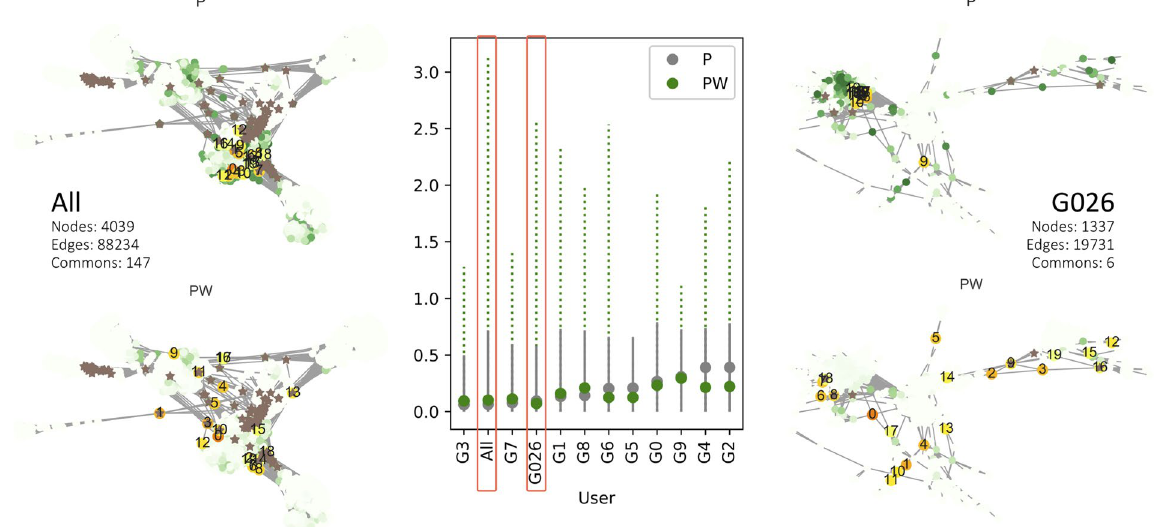
Figure 1. Comparison of the discriminating capacity of P and PW. The bar plot represents the ranges of P and PW for each of 10 Facebook users (G0–G9) and two combined networks of all 10 users and three users (G0, G2, and G6). The mean values of P and PW are represented by grey and green dots, respectively, with bars of these colors representing the range from the minimum to maximum values of the corresponding index (for detailed distributions of P and PW, see Supplementary Fig. S3). The numbers of nodes, edges, and common friends in each combined network are described in the figure. The star-shaped blown nodes in the networks represent common friends between ego users. Top 20 nodes are marked with orange gradation values with labels of the node ranking in each network and the other nodes are colored in green gradations. The thickness of orange and green represents the corresponding values of the nodes in each